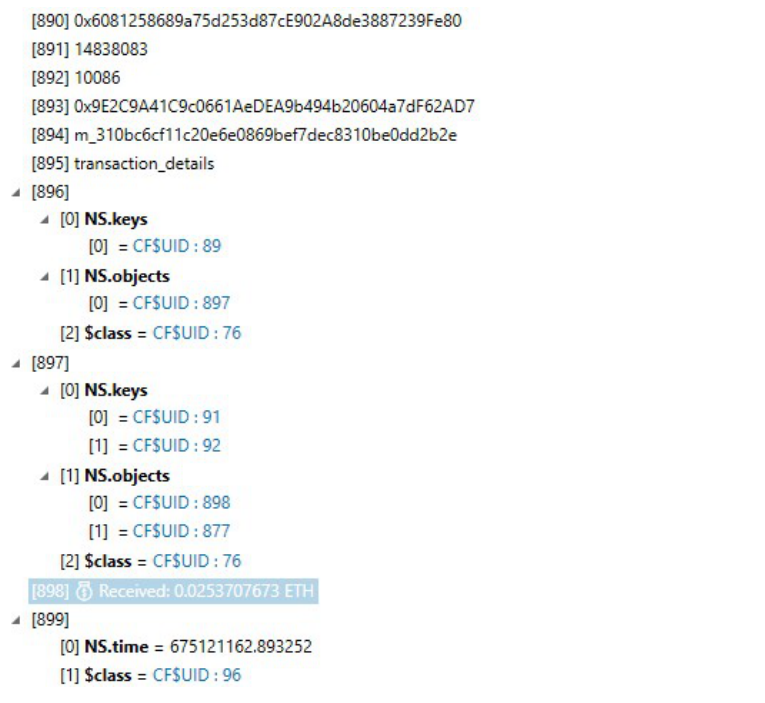
Figure 18. The 0.0253707673 ETH that was received from the Robinhood wallet.